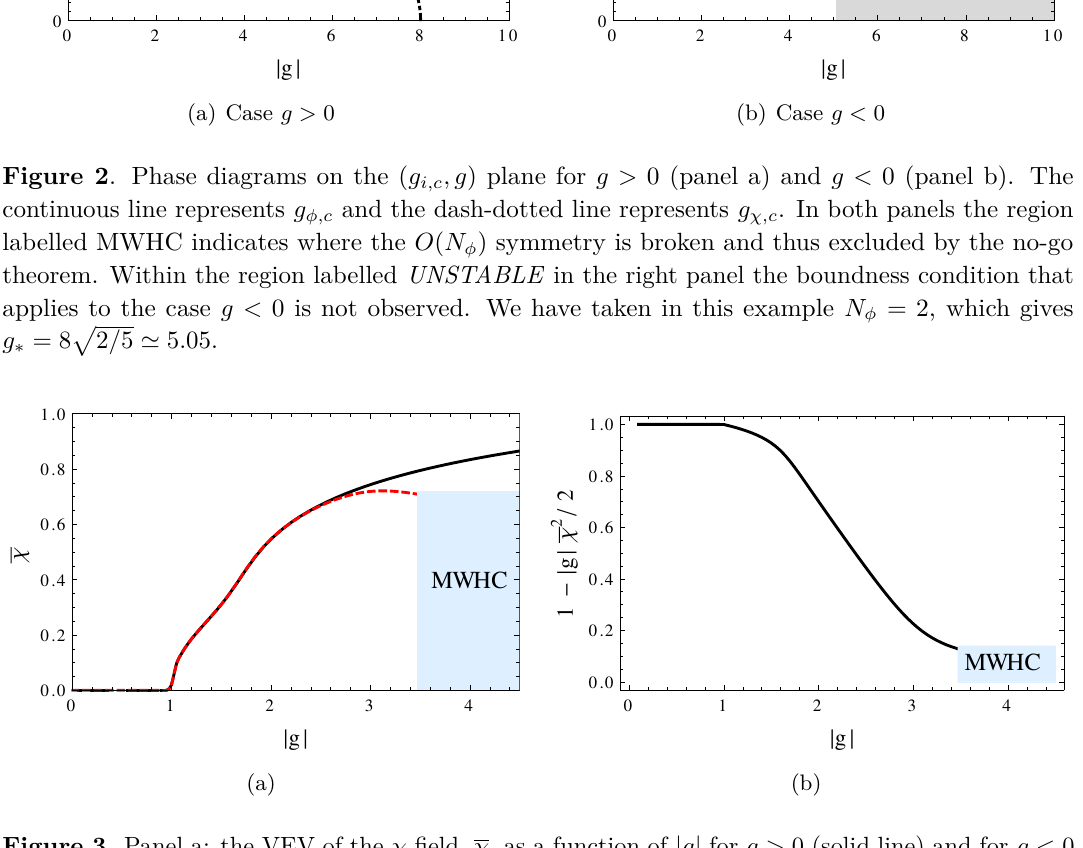
Figure 3 . Panel a: the VEV of the χ field, χ , as a function of | g | for g > 0 (solid line) and for g < 0 (dashed line). Panel b: Ω 2 /m 2 as a function of | g | in the case of g < 0 . The parameters chosen in χ both plots are N φ = 2 while the self-couplings are given by g i ( g ) = k i | g | , with k χ = 20 and k φ = 0 . 5